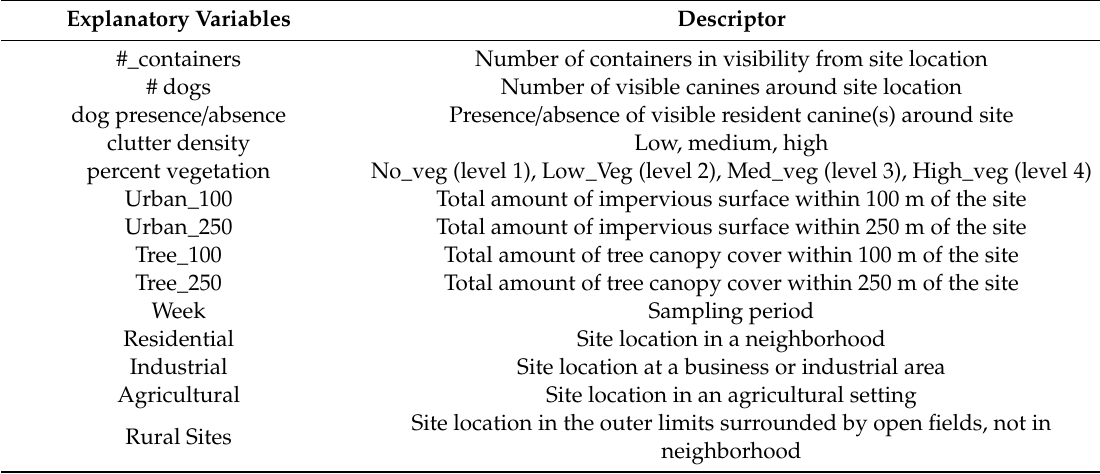
Table 1. Explanatory variables collected during summer 2017 for habitat preference